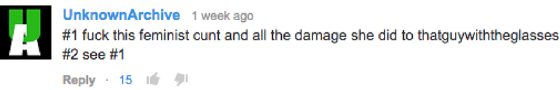
many toxic comments on